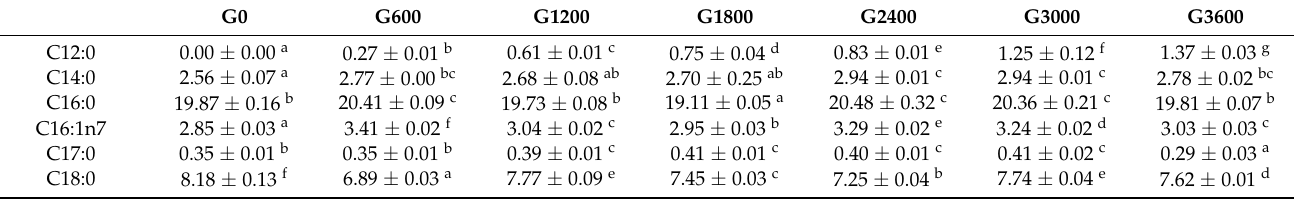
Table 4. Effects of dietary GML levels on fatty acid composition of juvenile grouper